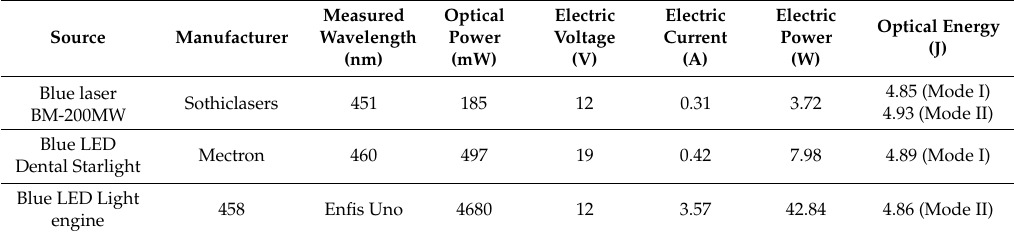
Table 2. Light sources used for curing restorative materials and measured characteristics: